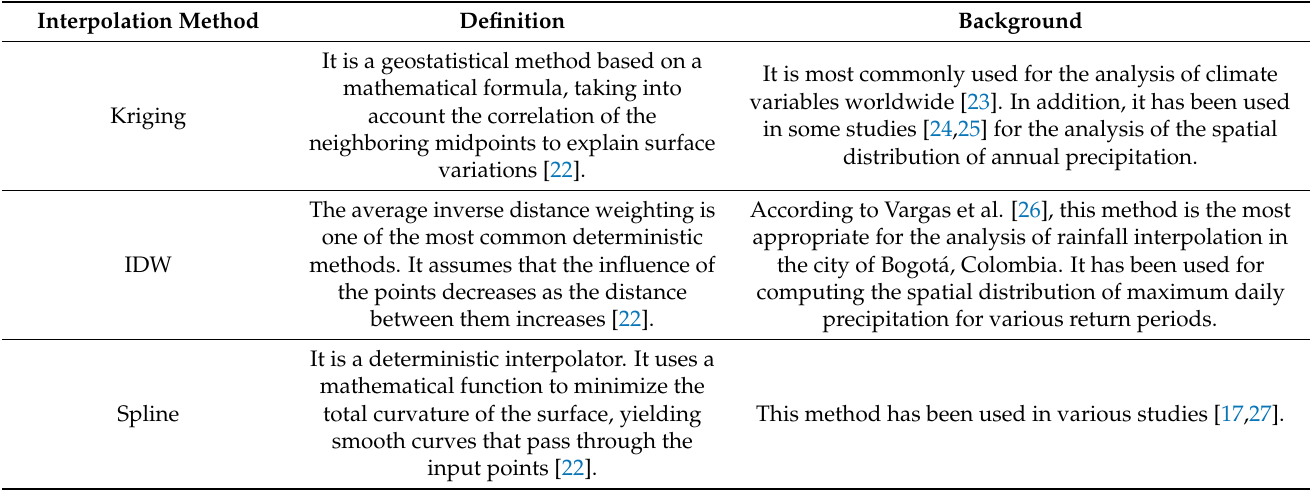
Table 3. Summary of the applicability of the IDW, kriging and spline interpolation